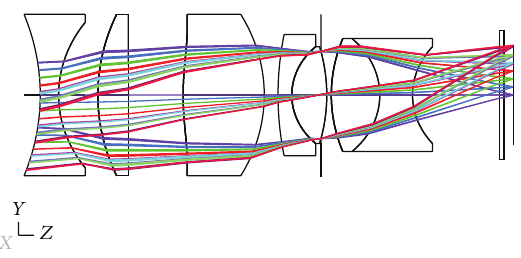
Figure 11: Single focus athermal